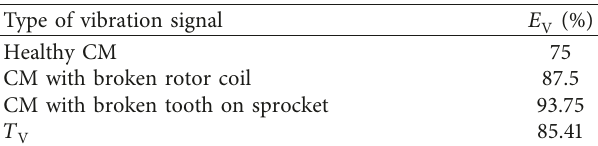
Table 8: The results of recognition of vibration signals—the sum of RSoV and the backpropagation neural network were used.